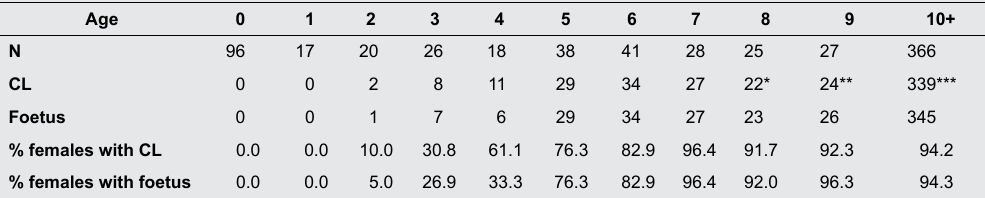
* Ovaries missing in one sample, but foetus present. ** Ovaries missing in two samples, but foetus present. *** Ovaries missing in six samples, but foetus present.